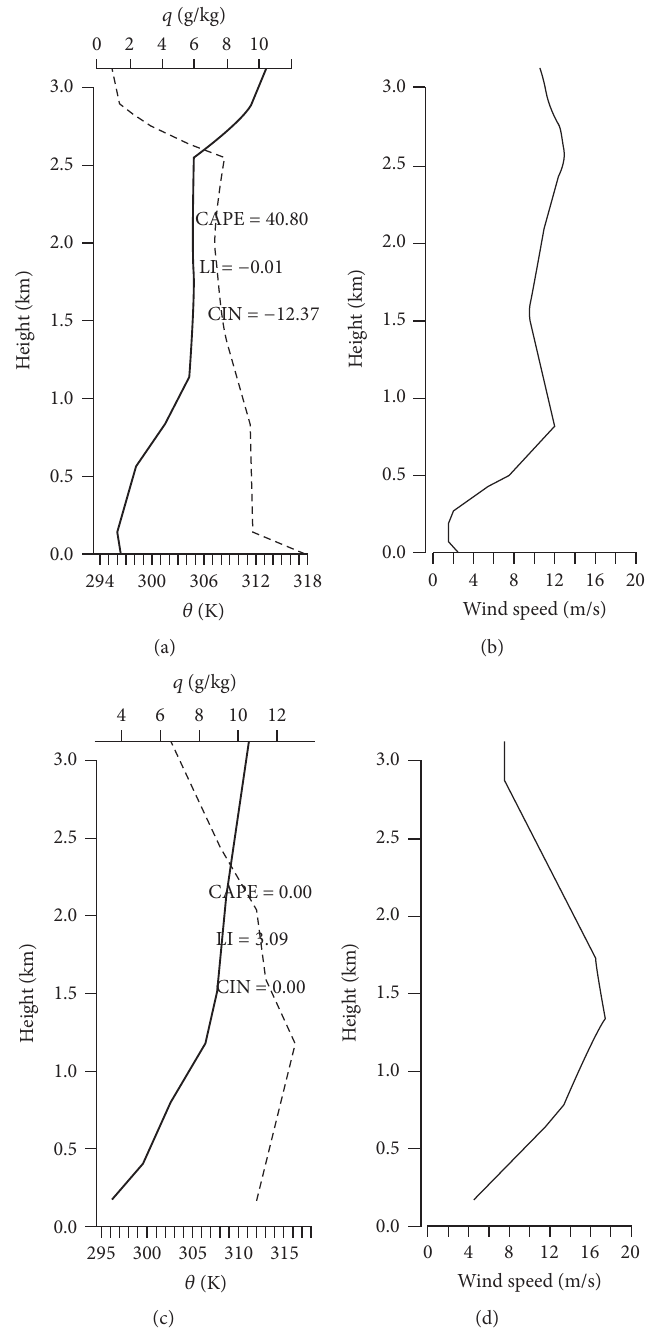
Figure 6: Vertical profiles of potential temperature (thick solid lines, in K), water vapor mixing ratio (dashed lines, in g kg −1 ), and wind speed (thin solid lines, in ms −1 ) from surface to 3 km AGL observed at 12Z 21 October 2008 for ((a)-(b)) SBPA and ((c)-(d)) SBFI.